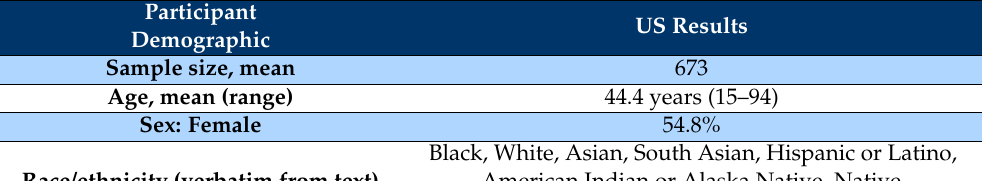
Table 3. Participant demographics reported by US studies (N = 22) [16,26,28,31,34,38–54]. Participant